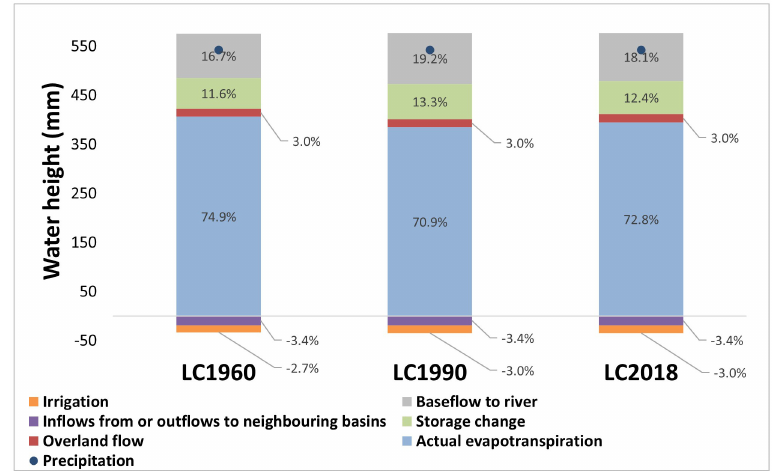
Figure 15. Water budget of Spercheios river basin for the three land cover case studies